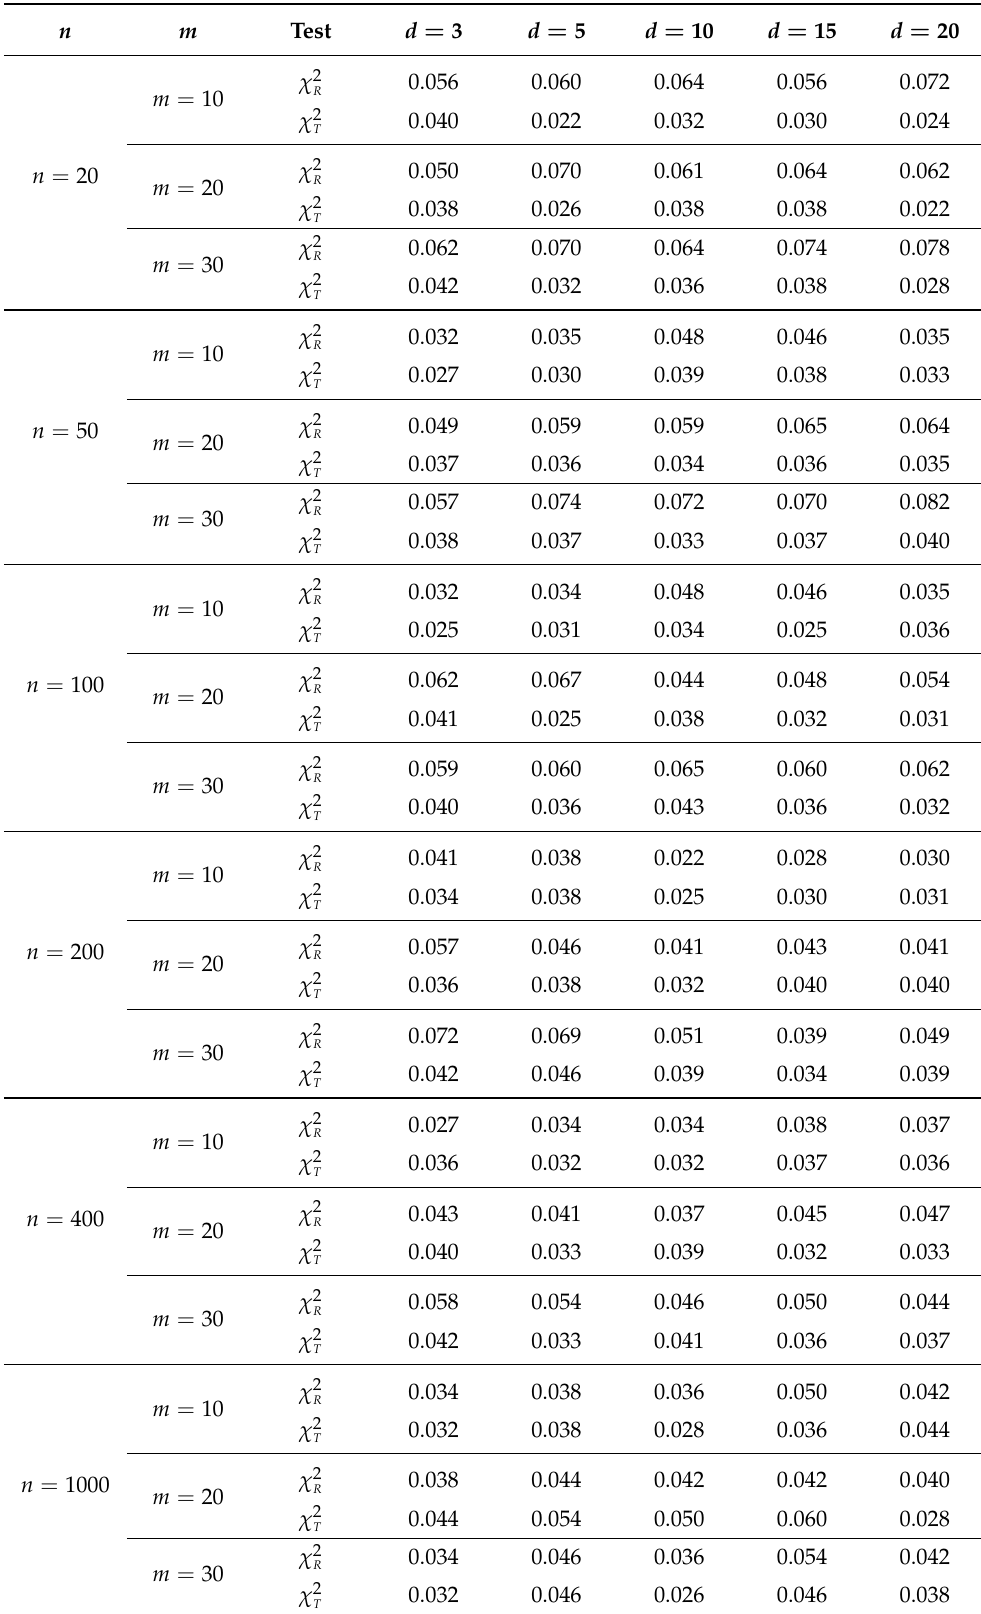
Table 1. Empirical type I error rates ( α =